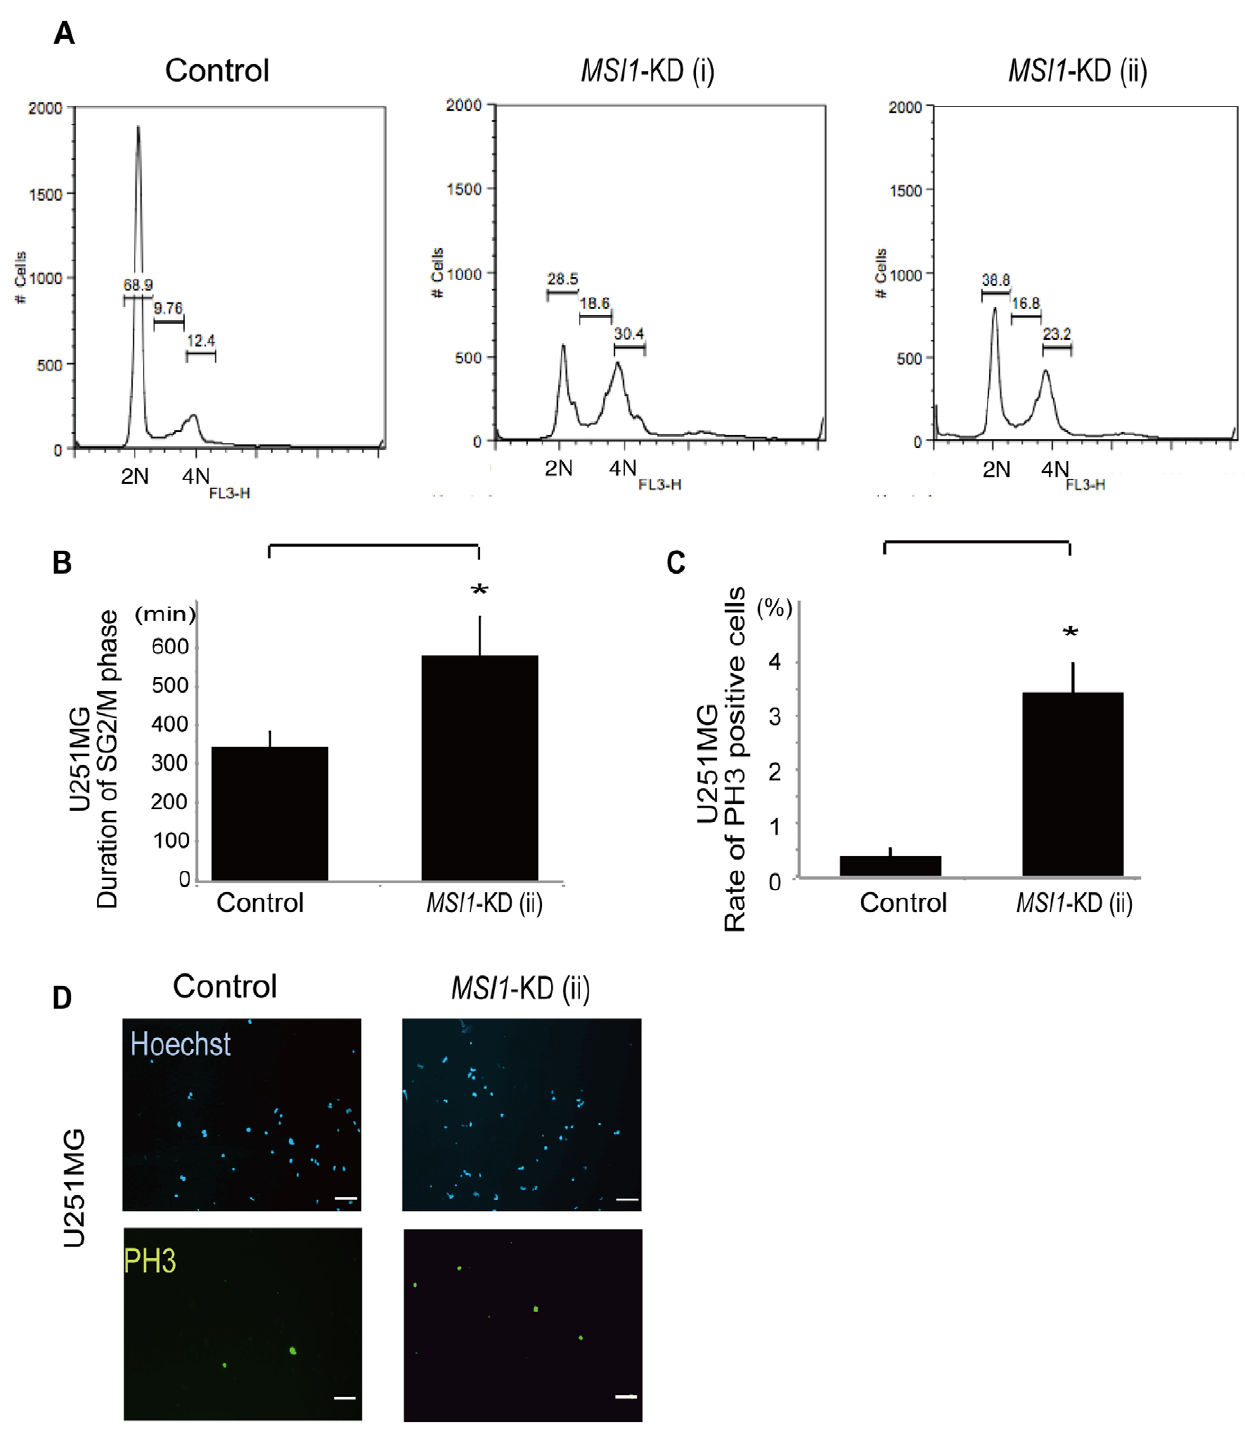
Figure 4. Knockdown of MSI1 induces G2/M arrest. MSI1 -KD cells were analyzed by fluorescence-activated cell sorting. A representative cell- cycle profile for each treatment is indicated. 2N represents the G0–G1 phase and 4N represents the G2/M phase. An increased number of MSI1 KD- positive cells accumulated in the G2/M phase. (B) Time-lapse microscopy using a fluorescent ubiquitination-based cell-cycle indicator (Fucci) probe system showed that MSI1 -KD cells retained the green fluorescence for a much longer time (4 days). Error bars represent SEM, *P , 0.01.The spheres were dissociated, and the dissociated cells were fixed to coverslips and stained for PH3 in U251MG cells (C and D). Cell counts are plotted as bar graphs. An average of 25 high-power fields was counted. Error bars represent SEM, *P , 0.01. (D) Representative images of control cells and MSI1 -KD cells stained for PH3 and Hoechst. There were more PH3-positive MSI1- KD cells than control cells. (Bar=500 m m).